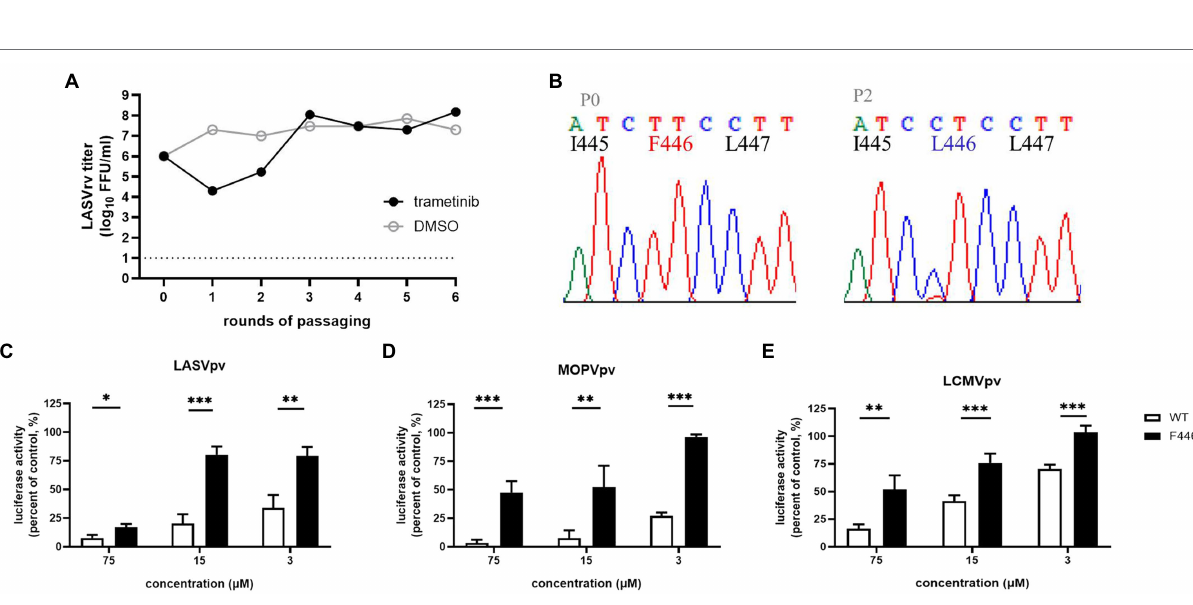
FIGURE 6 | F446L mutant in transmembrane domain of OW mammarenavirus conferred resistance to trametinib. (A) The adaptive mutant virus was selected by serially passaging LASVrv in the presence of 10 μ M trametinib. In a parallel experiment, the passaging of LUJVrv in vehicle served as a control. (B) Sequencing chromatograms of P0 and P2 viruses with the highlighted adaptive mutant. (C) LASV F446L pv conferred resistance to trametinib. (D) The corresponding F446L mutant MOPVpv conferred resistance to trametinib. (E) The corresponding F446L mutant LCMVpv was still sensitive to trametinib. Data are presented as means ± SD from 3 to 4 independent experiments ( *** p < 0.001; ** p < 0.01; and * p <